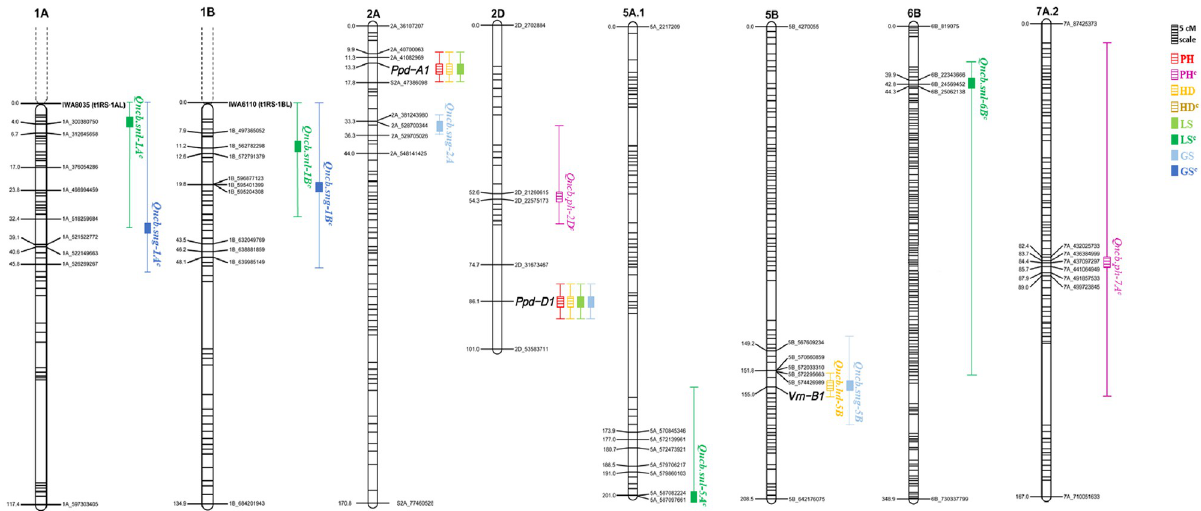
Fig 2. Genetic map location of QTL detected in this study. QTL locations and interval sizes are indicated by bars and brackets, respectively, on the right-hand side of each chromosome, and are based on the genetic marker information in Tables 2 and 3. c = covariate in standard interval mapping analysis; numbers after the underscore correspond to physical positions based on Chinese Spring RefSeq